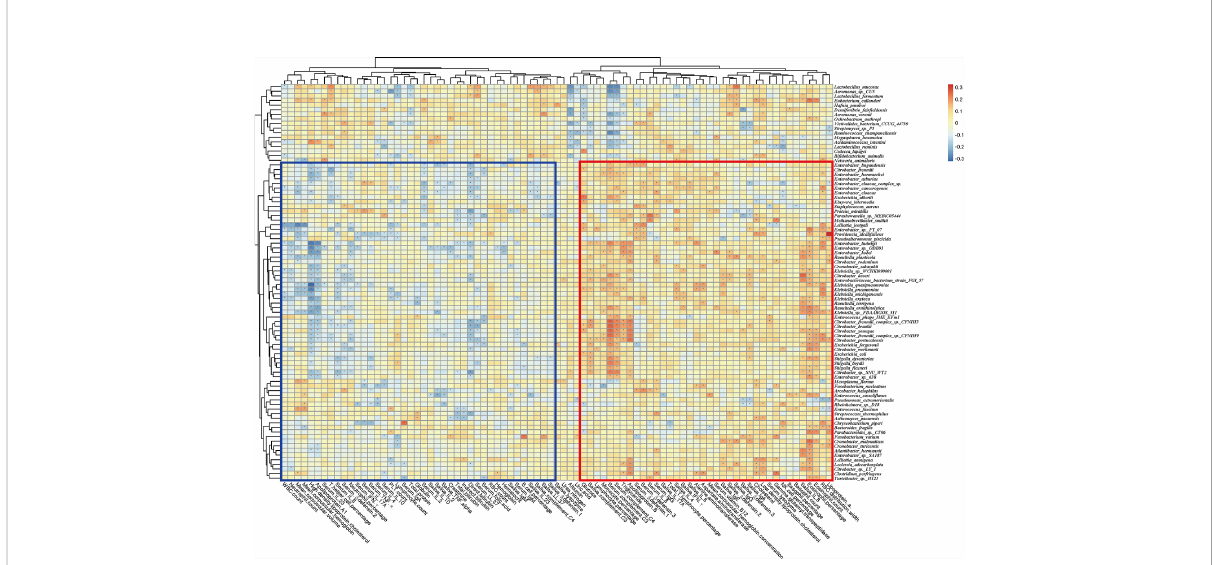
FIGURE 4 Correlation heatmap of gut microbiome-associated species and the blood and saliva factors between RAU patients and healthy controls. Blue boxes denote the cluster of negative correlation, those encompassed by the red box represent the cluster of positive correlation. The colors are proportional to the correlation strength, the variation from red to blue represent positive to negative trend. “ * ” means P